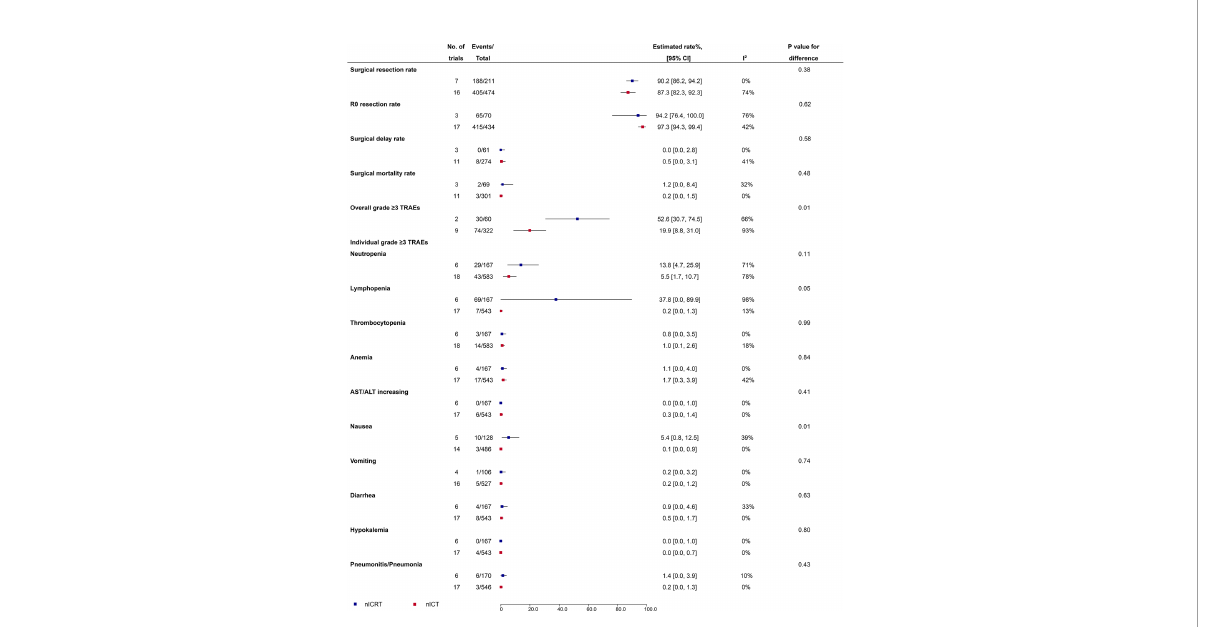
FIGURE 3 Surgical safety and grade ≥ 3 TRAEs of nICRT vs nICT. TRAEs, treatment-related adverse events; nICRT, neoadjuvant immune checkpoint inhibitor in combination with chemoradiotherapy; nICT, neoadjuvant immune checkpoint inhibitor in combination with